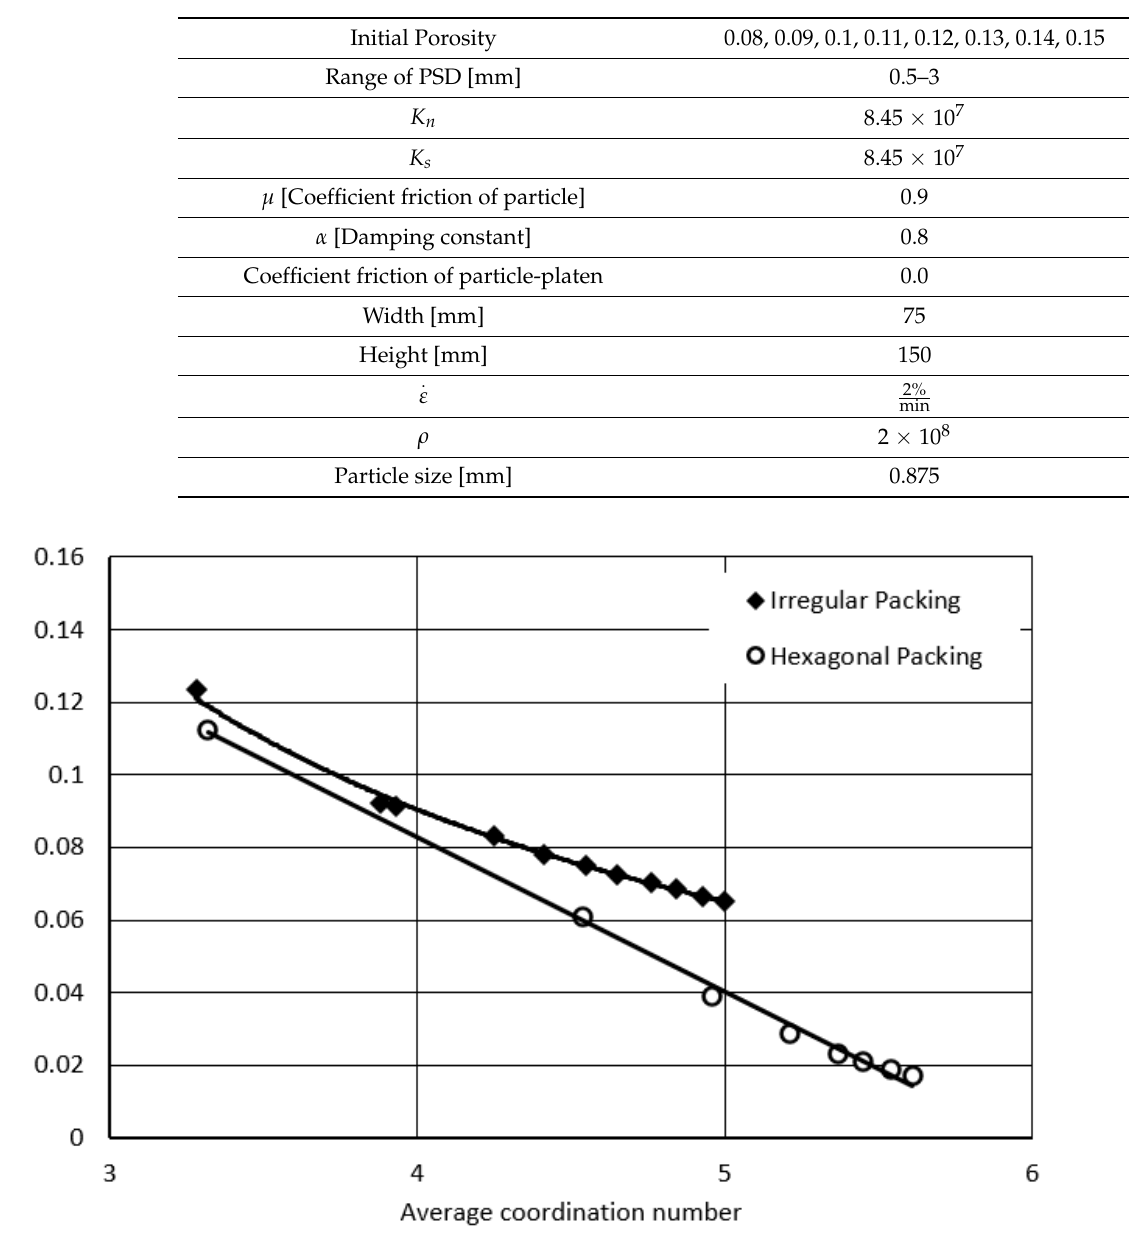
Table 3. The micro-mechanical properties of the hexagonal packing sample.